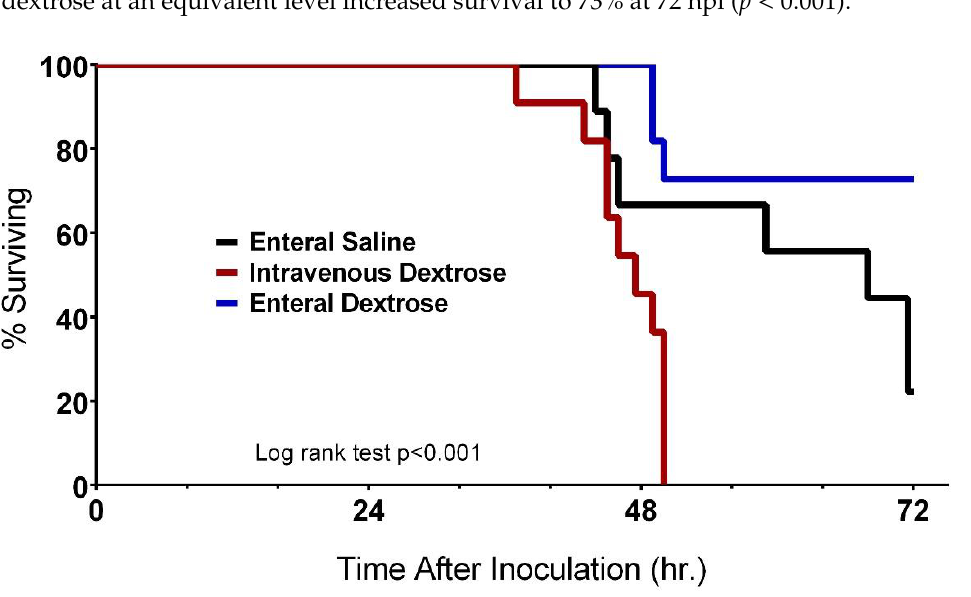
Figure 2. Effects of dextrose provision on survival following Klebsiella pneumoniae infection vary by route of provision. Mice receiving intravenous (IV) dextrose ( n = 11) had decreased survival compared to mice receiving enteral saline ( n = 9), but survival was increased in mice receiving enteral dextrose ( n = 11, p < 0.001).